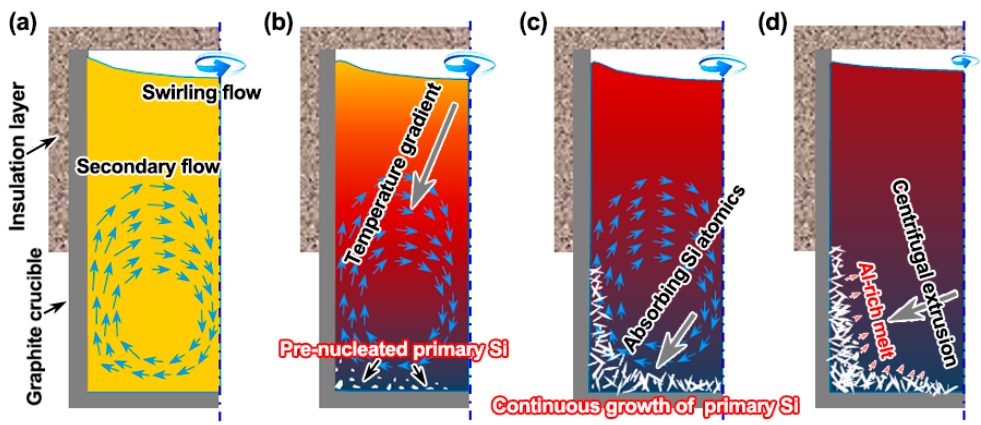
Figure 8. Schematic diagram of the electromagnetic segregation process of primary Si: ( a ) characteristics of flow pattern, ( b ) nucleation stage of Si crystals, ( c ) continuous growth stage of primary Si, ( d ) merger formation stage of Si-rich layer.